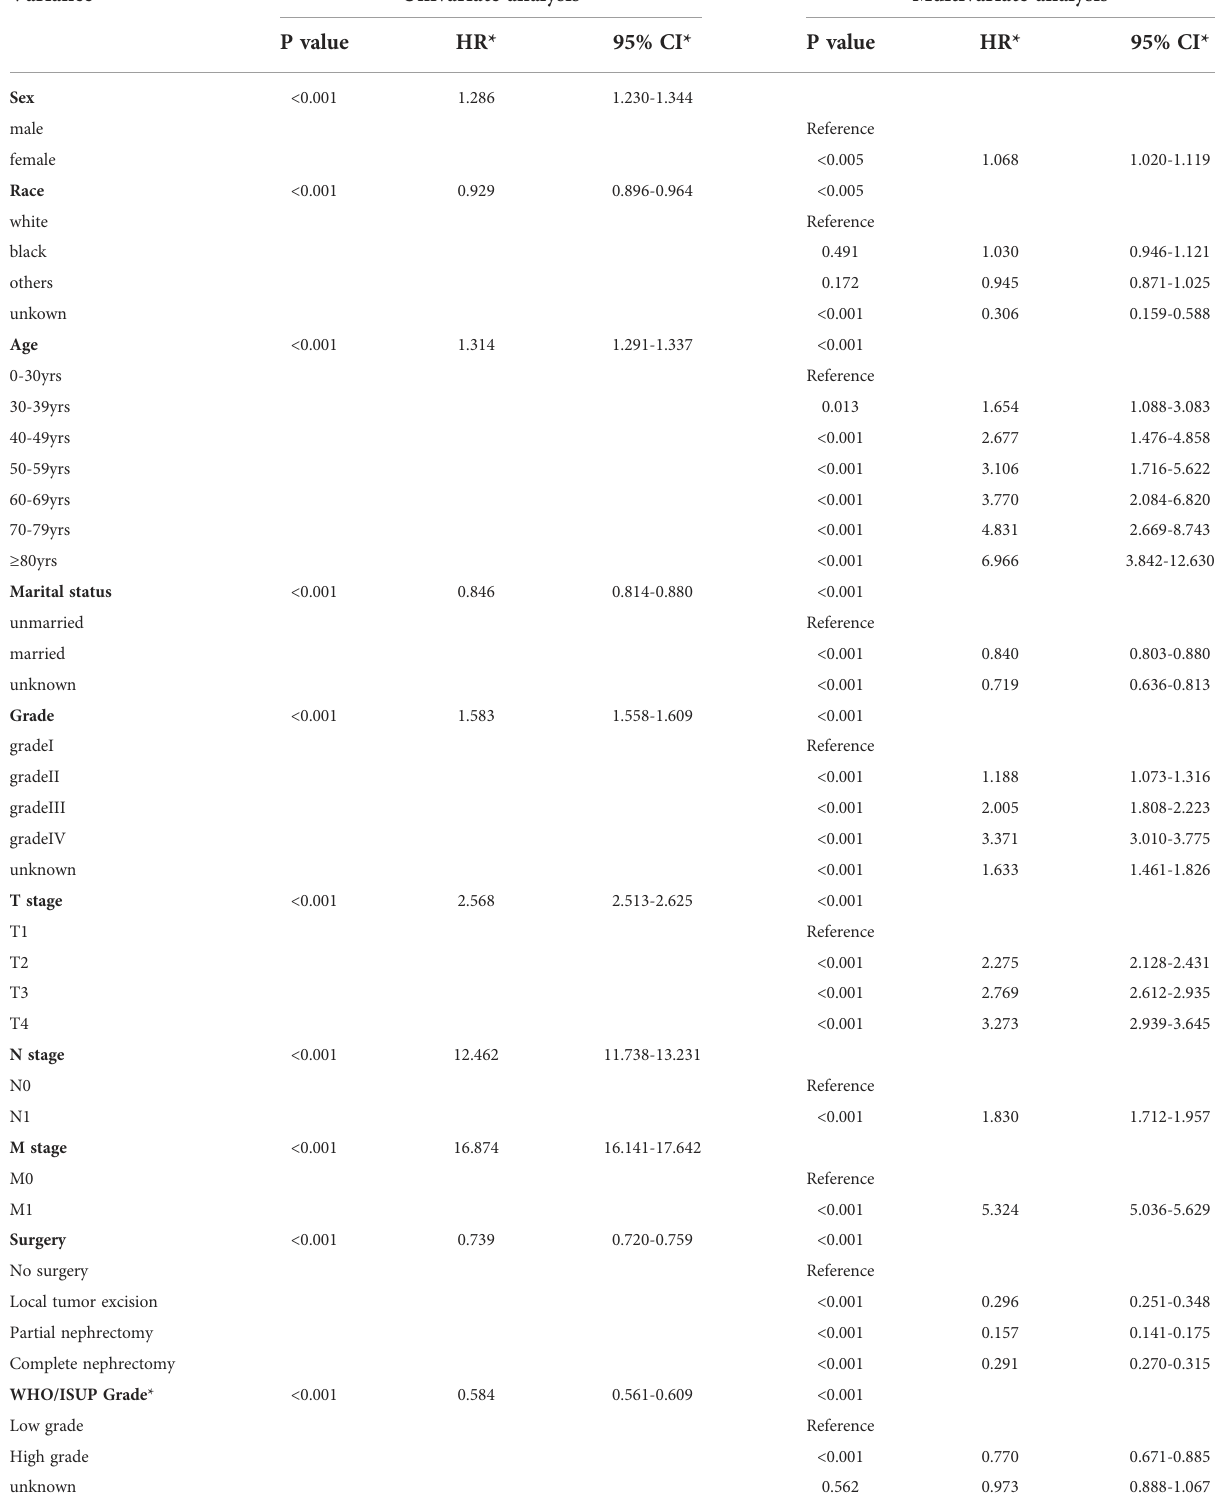
TABLE 3 Uni- and Multivariate Cox Regression Analysis of CSS